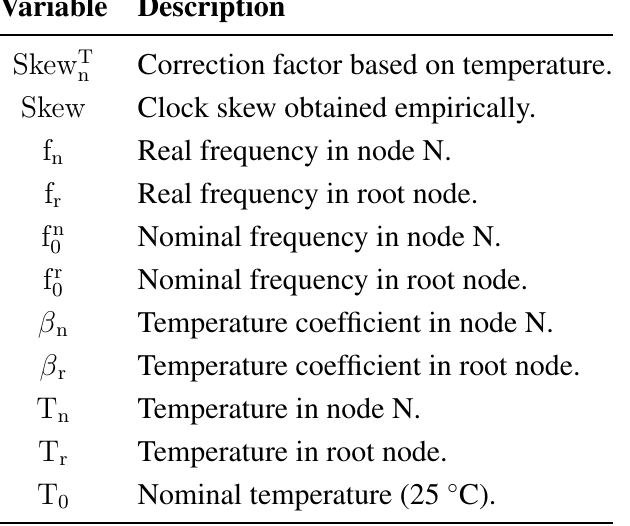
Table 1. Variables in the mathematical